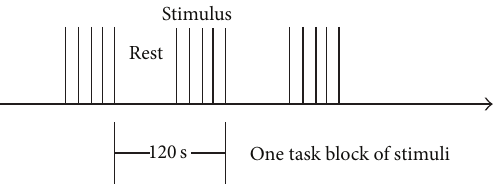
Figure 1: One task block duration of each stimulus event.